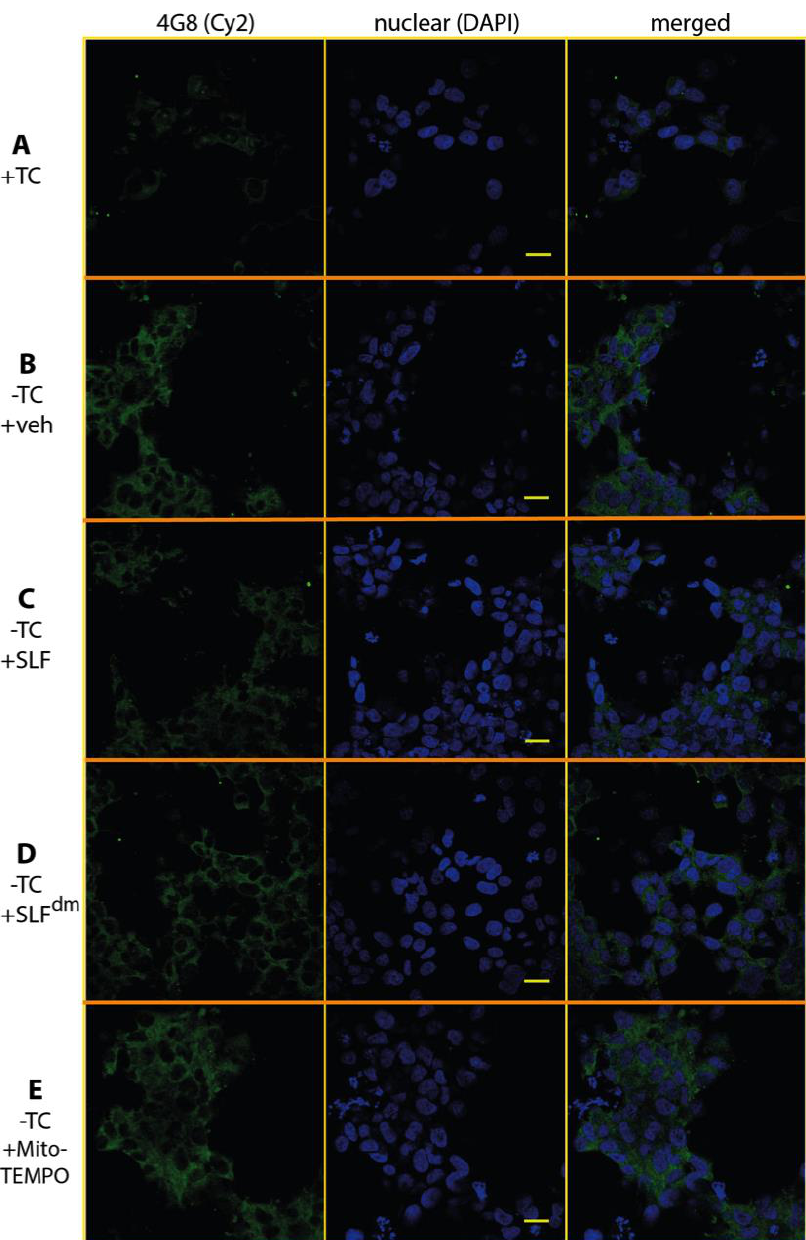
Figure 10. SLF reduces the presence of total intraneuronal Aβ in MC65 cells overexpressing APP. The presence of Aβ was detected by the conformational-independent antibody 4G8, which recognizes all forms of Aβ. Bound 4G8 antibody is indicated by the green Cy2 signal in the MC65 cells examined by confocal microscopy. In the absence of APP induction, there is only slight staining by 4G8 ( A ). With overexpression of APP, Aβ staining is clearly evident ( B ). Addition of SLF to MC65 cells overexpressing APP results in a dramatic decrease in the total Aβ ( C ). Relative to SLF, the ability of diamagnetic SLF to reduce total Aβ is markedly less ( D ), which suggests that ROS promotes Aβ generation and/or inhibits Aβ clearance. Row ( E ) shows that MitoTEMPO attenuates total Aβ slightly better than SLF dm , which supports the notion that ROS levels significantly affect Aβ metabolism. The left column is the Cy2 stain, the middle column is the DAPI nuclear stain, and the right column is a merging of the first two columns. Scale bar represents 20 μm.